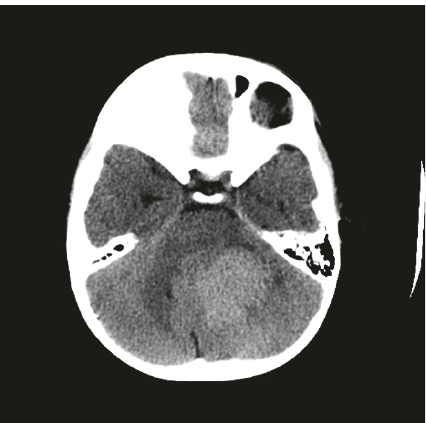
Figure 1: Axial CT of the brain revealed left-sided posterior fossa hyperdense mass compressing the fourth ventricle and brainstem.